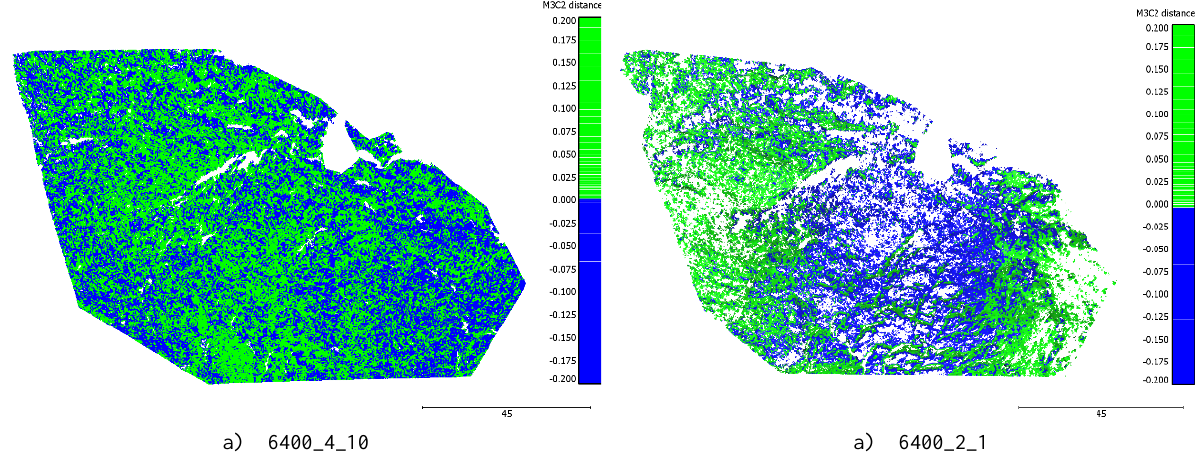
Figure 8 – Colour maps of the distances computed with the M3C2 plugin in respect to the reference model of the point clouds generated with ISO 6400: a) aperture 4 and time of exposure 10 s and b) aperture 2 and time of exposure 1